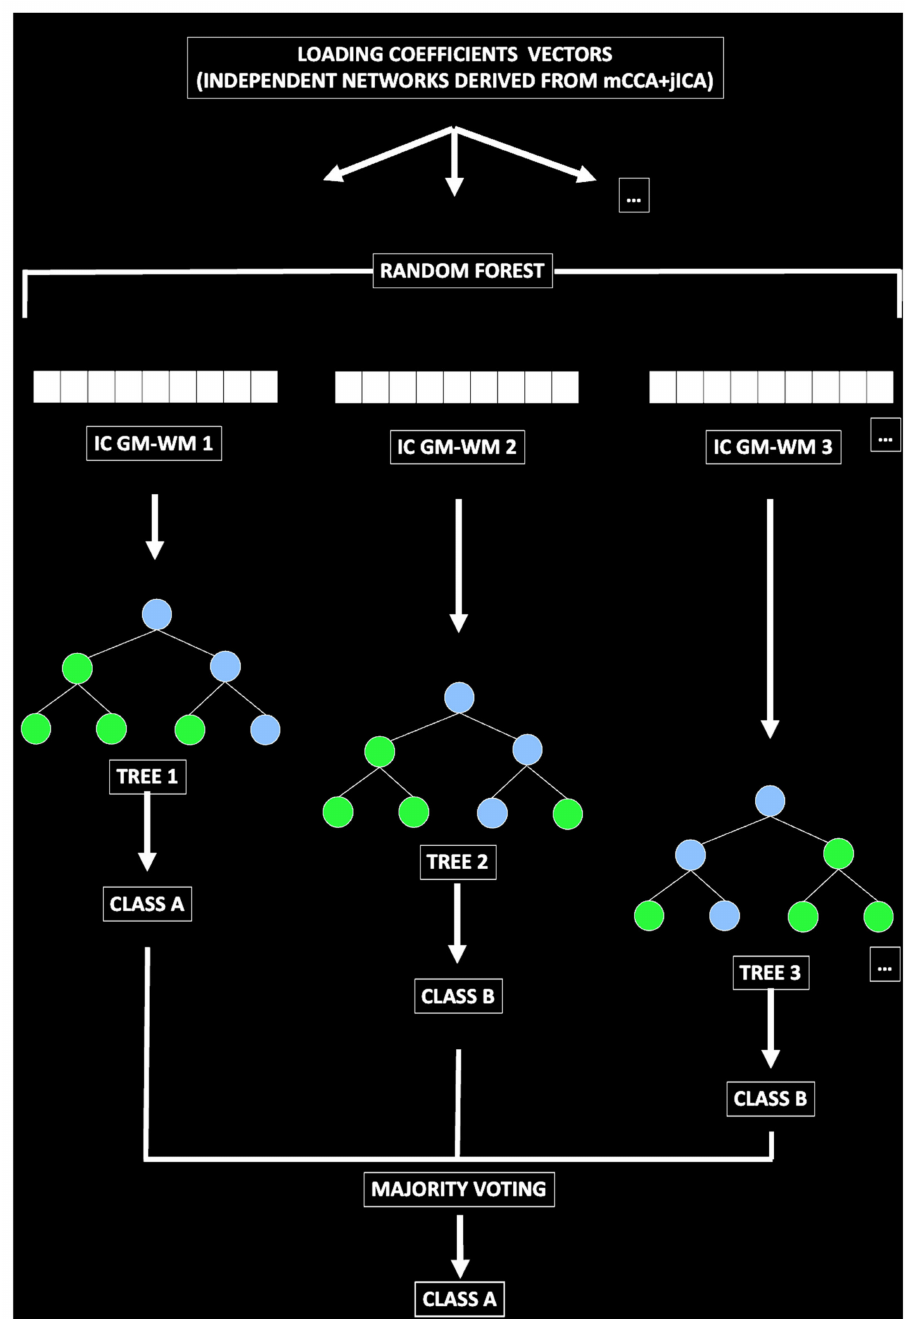
Figure 2. Predictive model generation . The loading coefficients of the GM-WM networks derived from mCCA+jICA were entered in a random forest classification model to predict BPD diagnosis. Several trees were generated to classify the labels BPD and HC. Each tree voted for that class. The forest then chose the classification having most of the